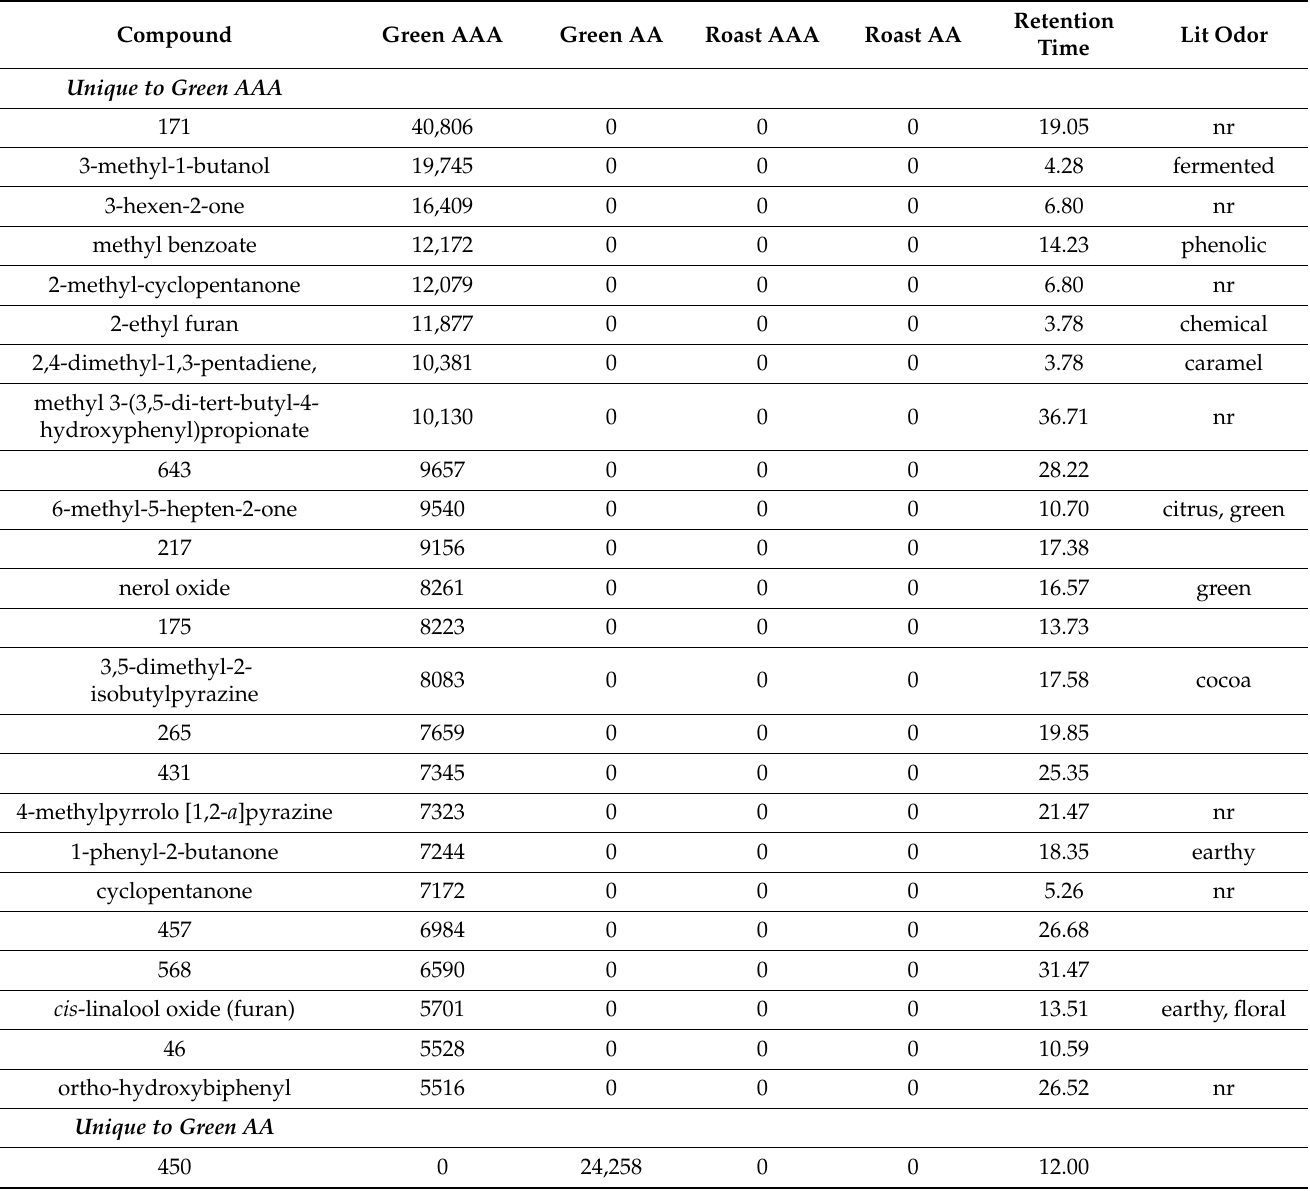
Table 1. Compounds unique to Green AAA and Green AA, their relative abundance, retention time, and odor